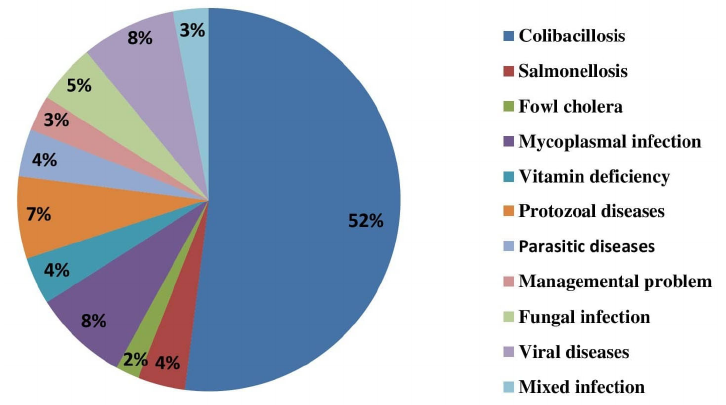
Fig. 1. Frequency of different poultry diseases diagnosed tentatively on the basis of clinical signs and postmortem lesions